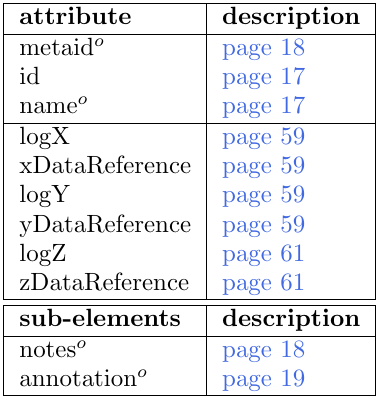
Table 2.29: Attributes and nested elements for surface. xy o denotes optional elements and attributes.